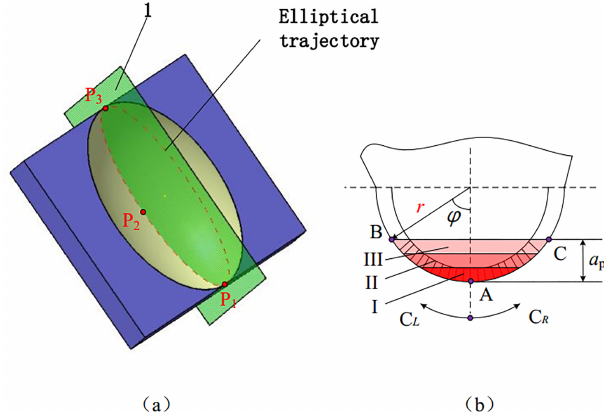
Figure 3. Wear regions of elliptical vibration